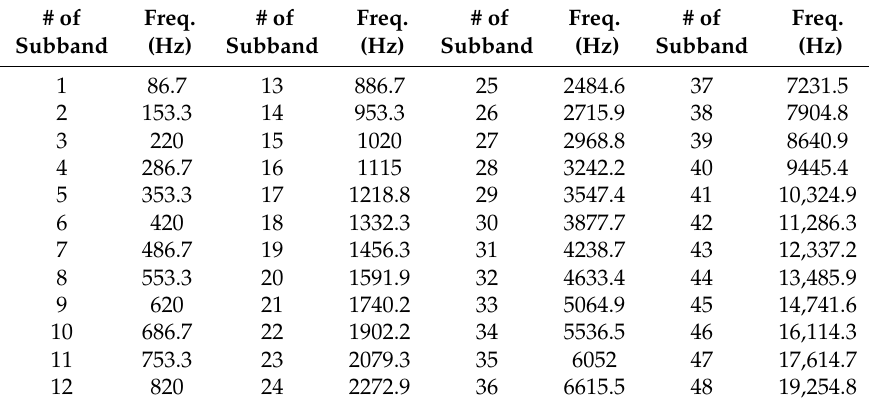
Table 1. Relation between the M = 48 subbands used from the Mel filter-bank parameterization and its central frequency in Hz. # of Freq. # of Freq. # of Freq. # of Freq. Subband (Hz) Subband (Hz) Subband (Hz) Subband